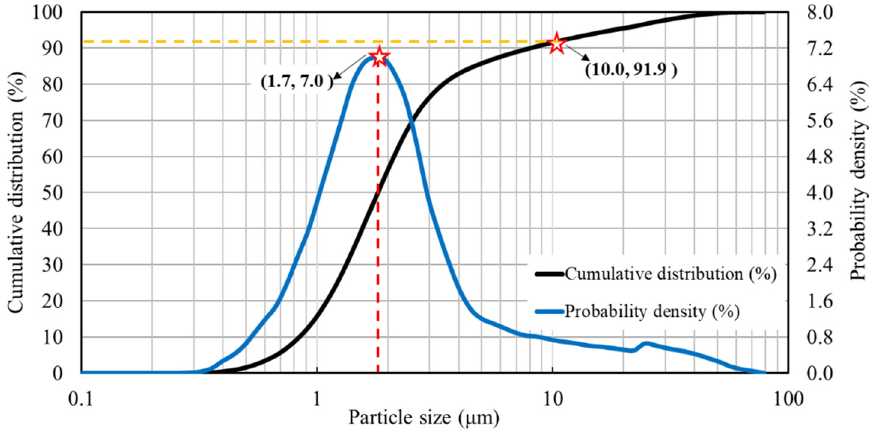
Figure 5. Cumulative distribution and probability density of emulsified asphalt.